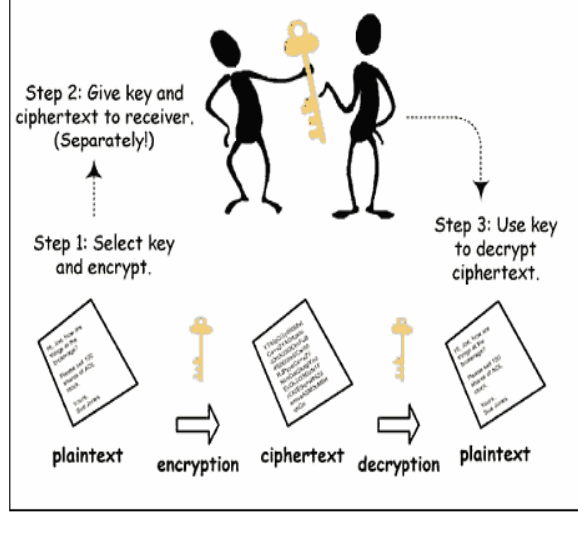
Fig. 2. Symmetric-key Cryptography